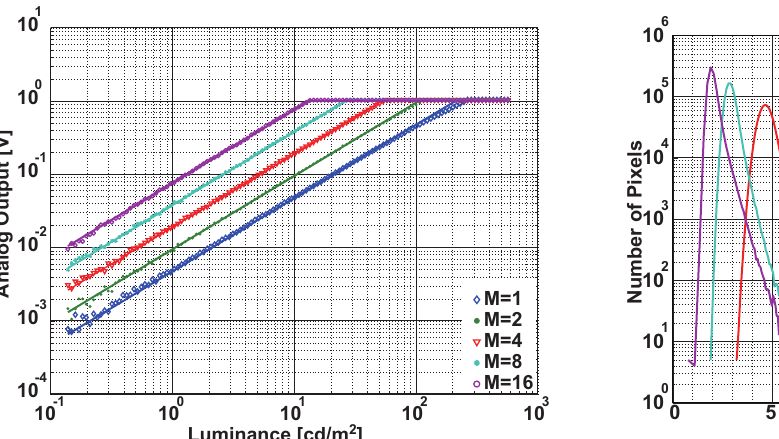
Figure 10. Characteristics in SI-CMS mode.